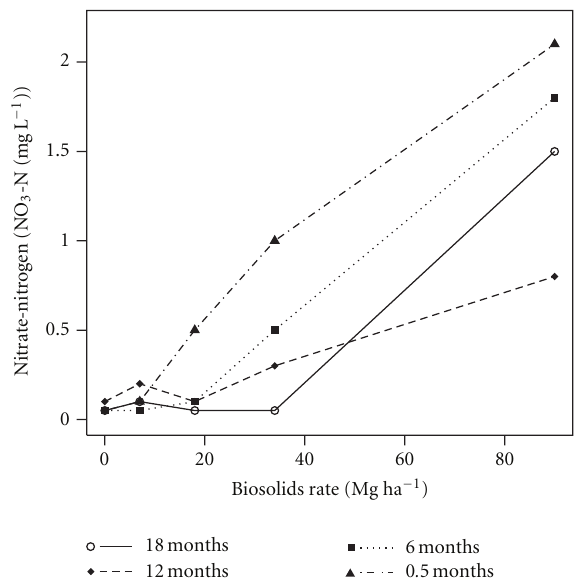
Figure 13: Orthophosphate, PO 4 − 3 -P, and nitrate nitrogen, NO 3 − - N, in soil water leachate from lysimeters with either an Armesa taxadjunct soil or a Stellar taxadjunct soil treated with 0 to 90 Mgha − 1 (adapted from